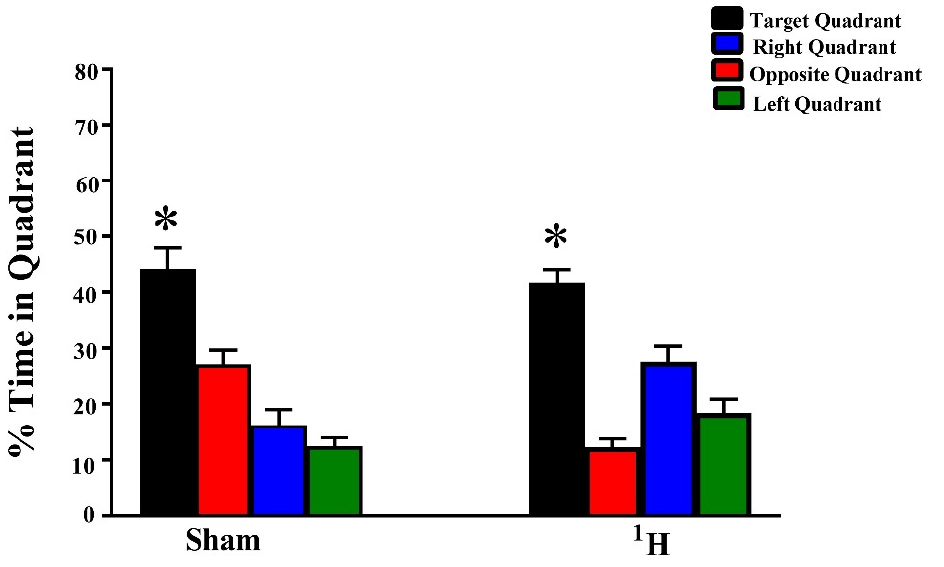
Figure 6. Morris water maze probe trials on day 5. Both the sham- and fractionated 1 H-irradiated mice spent more time in the target quadrant compared to the right, opposite and left quadrants. * p < 0.001.